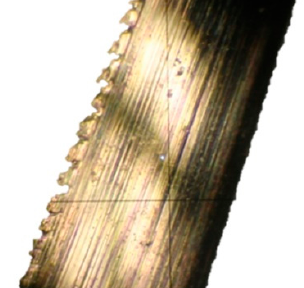
Figure 19. View of the chip shape after longitudinal turning without coolant (36 HRC).